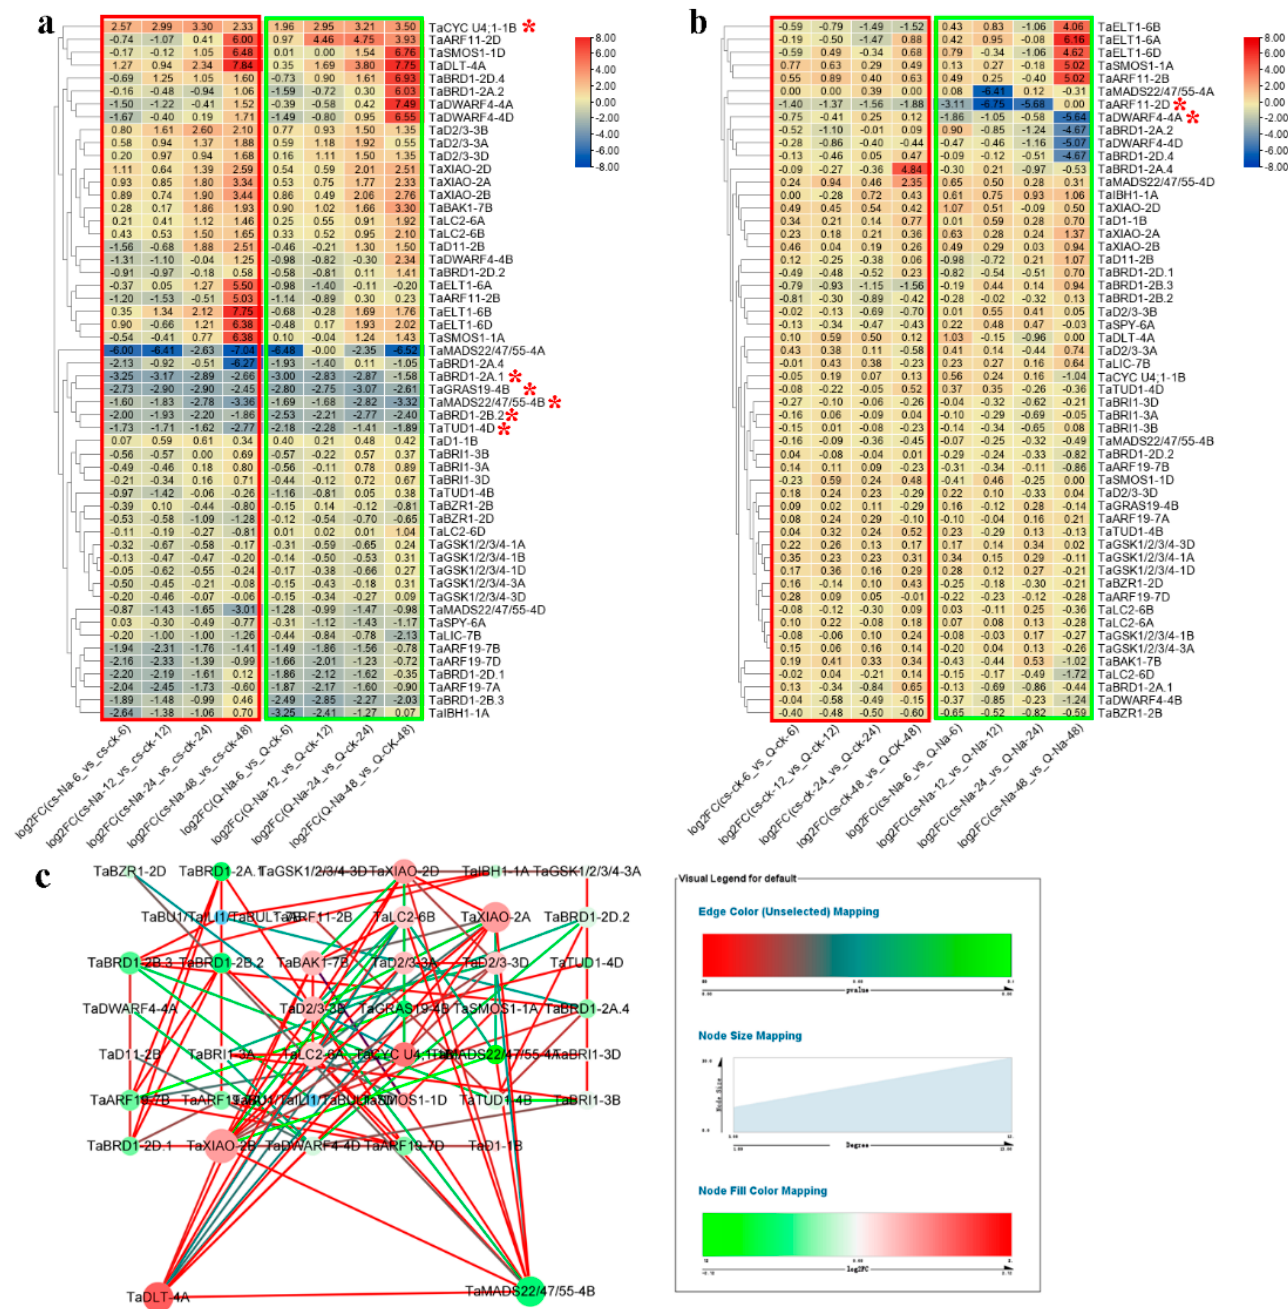
Figure 8. Expression analysis of wheat BR-related genes in response to salt. ( a ) DEG analysis between control and salt-treated groups in CS and QM. DEGs in both CS and QM at all time points are marked with red asterisks. ( b ) DEG analysis between CS and QM. DEGs in both CS and QM at all time points are marked with red asterisks. ( c ) Gene co-expression network analysis of wheat BR-related